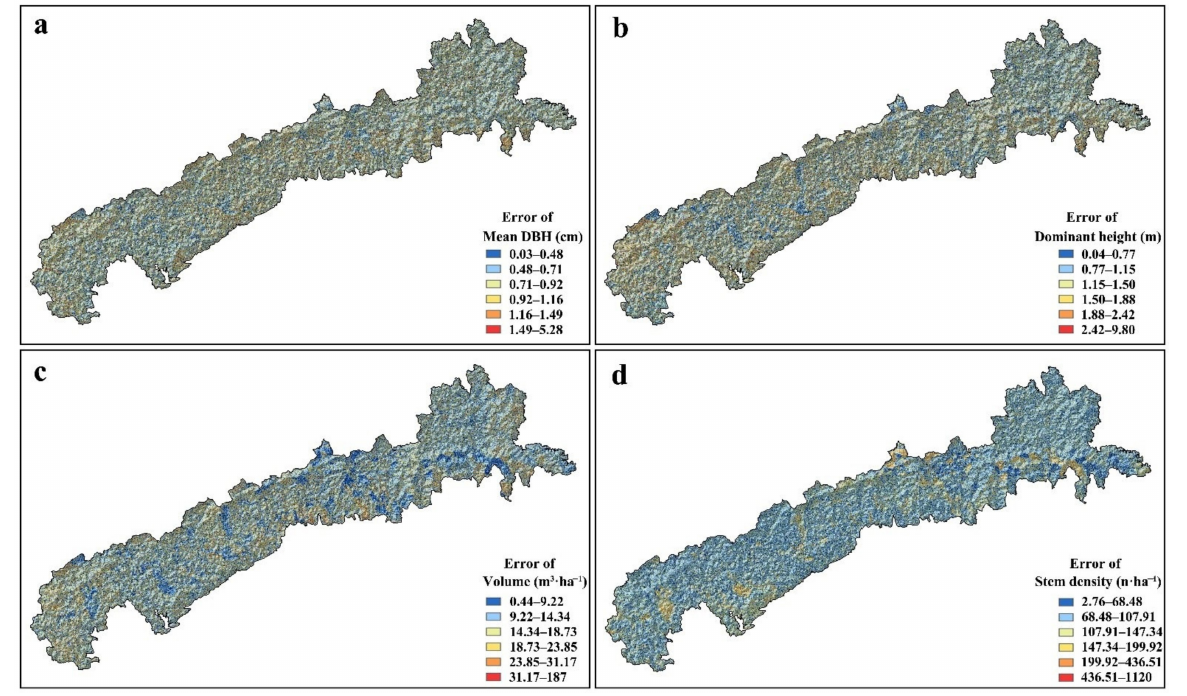
Figure 9. Uncertainty maps of forest structural parameters. Subfigures ( a – d ) represented the uncer- tainty maps of mean DBH, dominant height, volume and stem density, respectively.